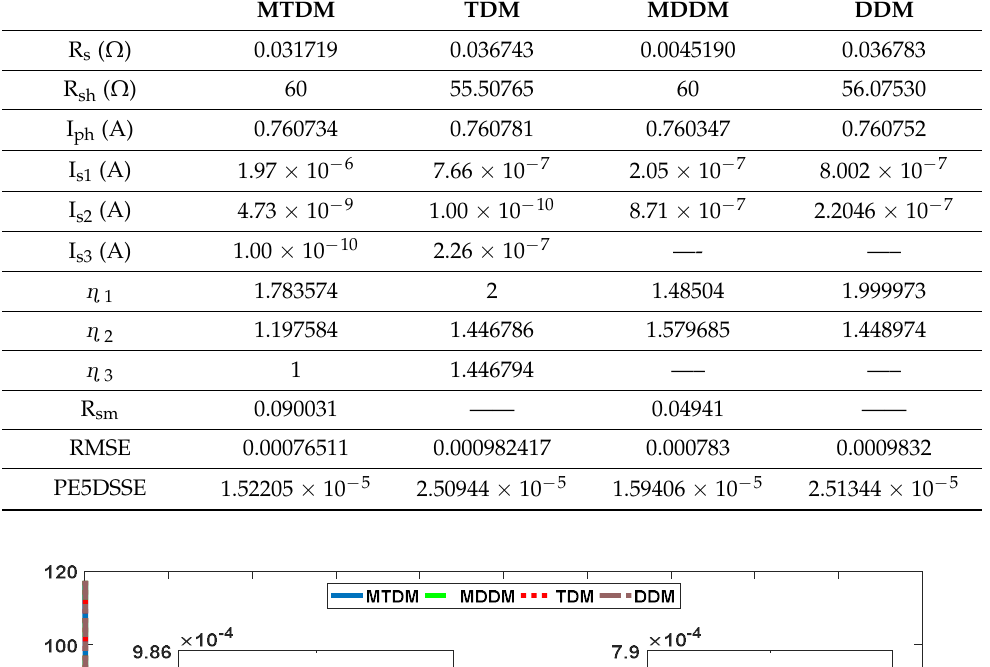
Table 2. Estimated parameters and RMSE of WHO for original and modified models.